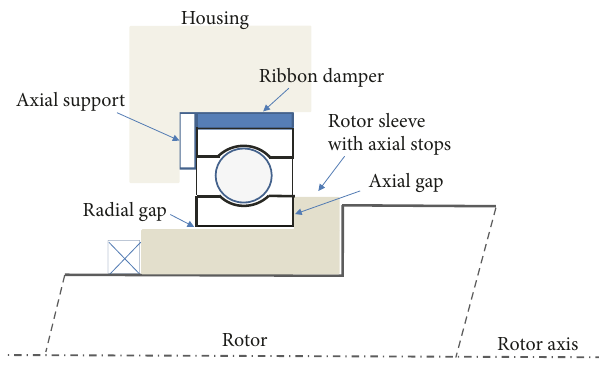
Figure 6: Schematic representation of the auxiliary system.